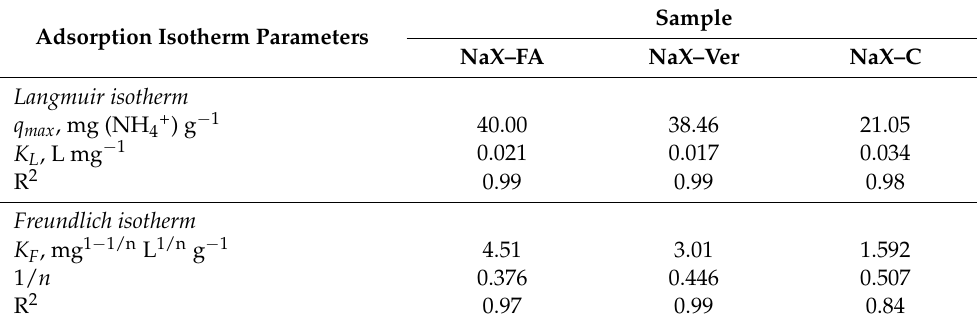
Figure 6. The correlation of experimental data with the adsorption kinetic models: pseudo-first-order (solid line) and pseudo-second-order (dashed line). Error bars indicate the standard deviation of duplicate measurements. Table 5. Adsorption isotherm parameters of NH 4+ ion adsorption onto zeolites NaX–FA, NaX–Ver, and Table 4. Adsorption kinetics parameters of NH 4+ ion adsorption onto zeolites NaX–FA, NaX–Ver,